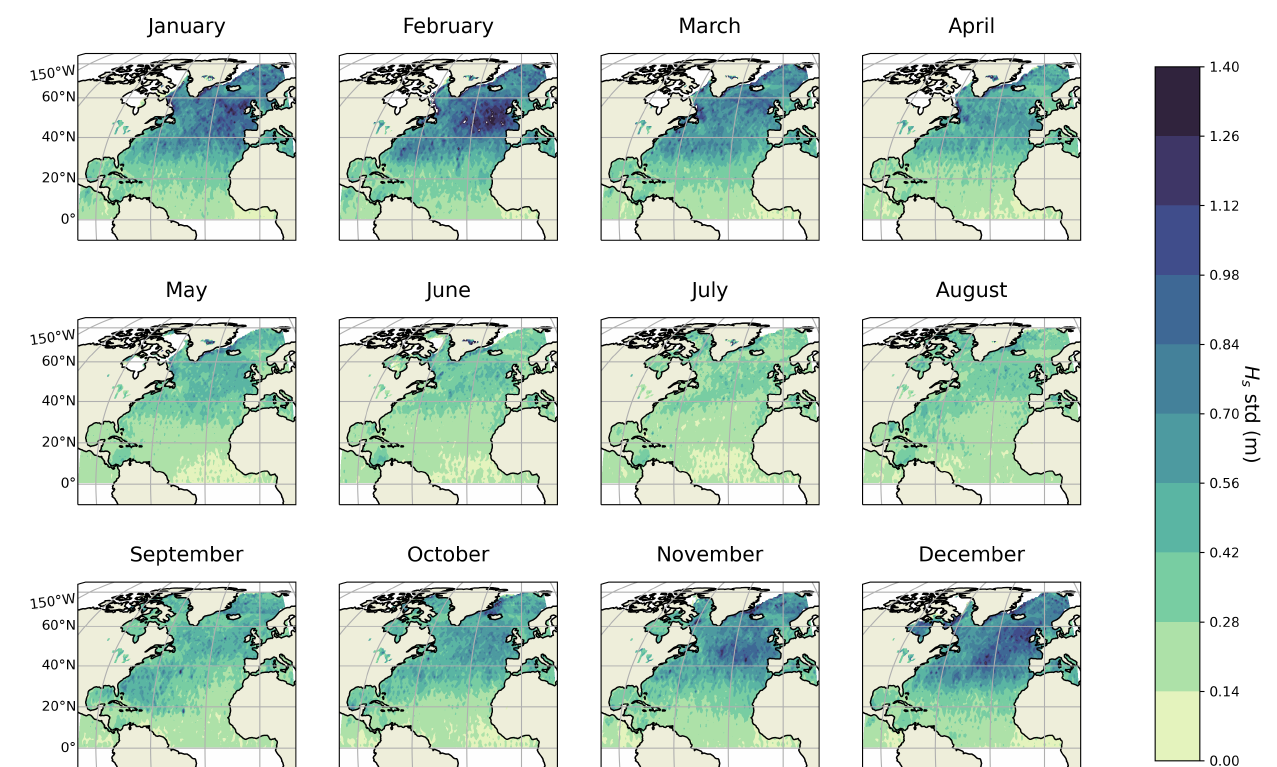
Figure 5. Standard deviation of H s (m) obtained from each individual month over the period 1993–2018 using altimeter